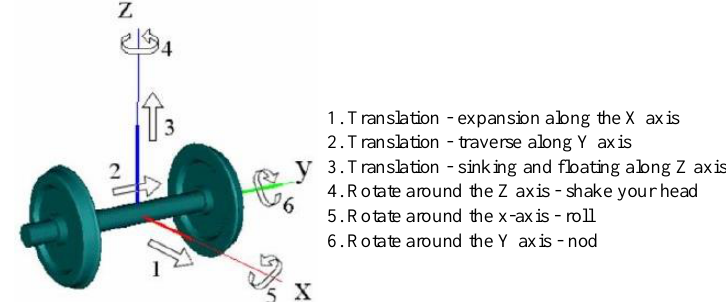
Figure 7. Wheel set with six degrees of freedom.